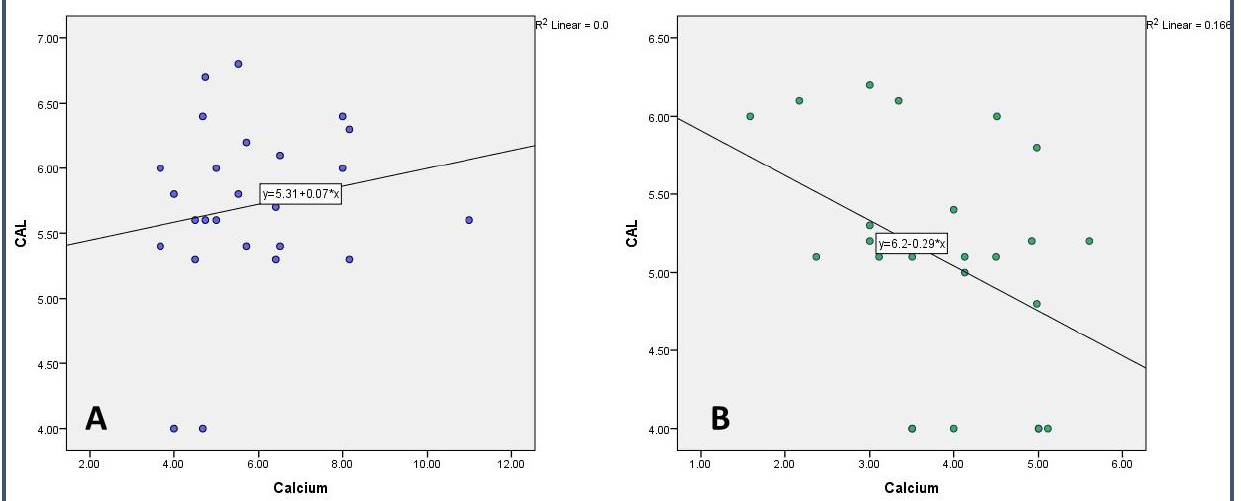
Figure 2. Correlational analysis of Calcium with Clinical Attachment Loss in ( A ) Smokers and ( B ) Non-Smokers.